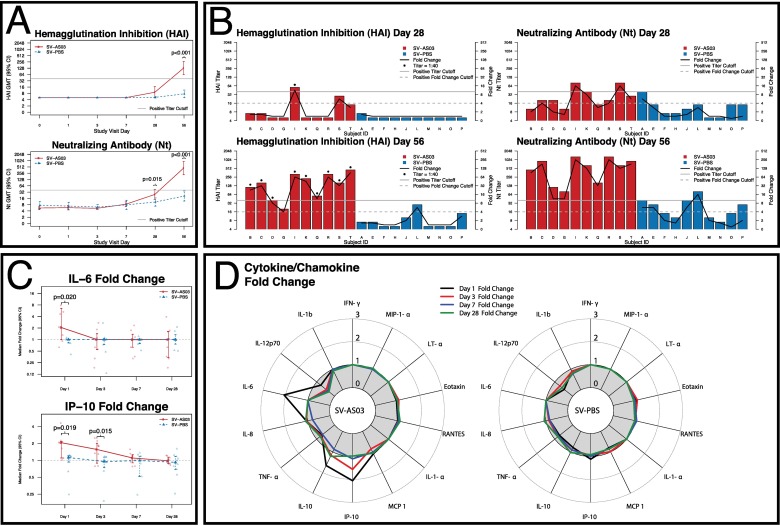
AS03-adjuvanted H5N1 vaccination induced early IP-10 and IL-6 serum cytokine and later protective immune responses relative to non-adjuvanted vaccine.Serum Antibody and cytokine responses by vaccine group (red: SV-AS03 (n = 10), blue: SV-PBS (n = 10)). (A) HAI and Nt antibody GMT and 95% CI at each time point by vaccine group; p-values are based on two-sided t-test on the log scale adjusting for unequal variances if necessary. No multiple-testing adjustment was carried out. (B) Hemagglutination inhibition (HAI) and neutralizing antibody (Nt) titers in individual subjects at days 28 and 56 by vaccine group; titer is represented by bar height (left y-axis) while fold change from baseline is shown as a connected black line (right y-axis), cut offs are indicated by grey lines (solid: 1:40 titer, dashed: 4-fold change). (C) Median fold change and 95% bootstrap CI for serum cytokines/chemokines with significantly different responses at each post-vaccination time point by vaccine group; individual subject fold changes are shown in lighter colors; p-values are based on two-sided non-parametric exact Wilcoxon rank-sum test. No multiple-testing adjustment was carried out. (D) Radar chart of cytokines/chemokine median fold changes at each time point by vaccine group.